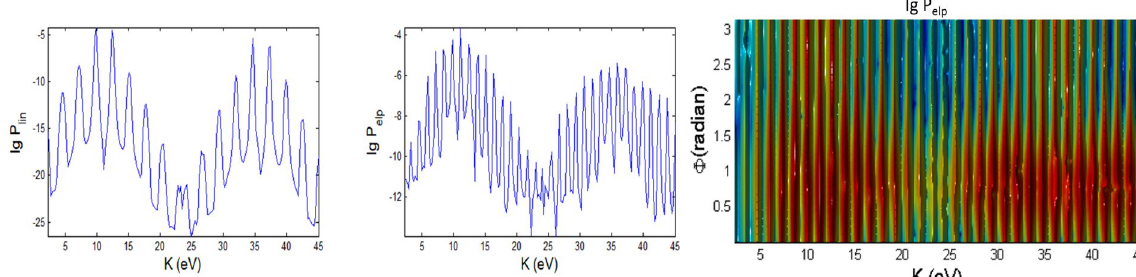
Figure 3. Photoionization probability versus angle Φ at Θ = π /2 (in x-y plane) and kinetic energy ( K ) with t p = 100 fs for linear and elliptical polarized lasers for the Case A (intermediate regime) whose laser field amplitude  and frequency ω are tabulated in Fig. 1. The 2D spectra correspond to the end point of Φ = π . Here, 0 there is no first and second order Stark effects, = = a b 0 and the CEP phase ϕ = 0. We do not show the nlm nlm 3D plot for linear polarization since it has azimuthal symmetry and therefore independent of angle Φ .